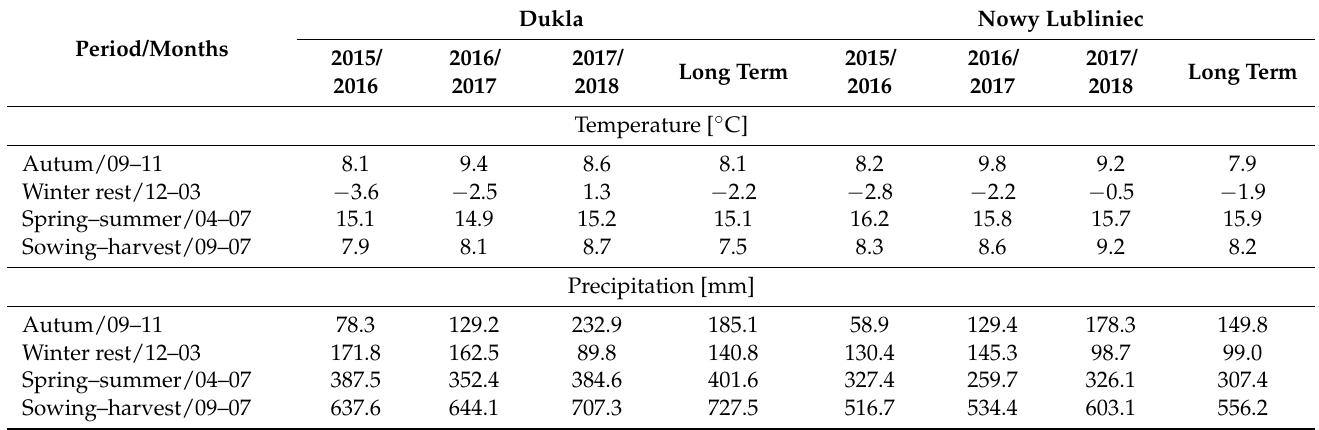
Table 2. Temperature and precipitation in the experimental